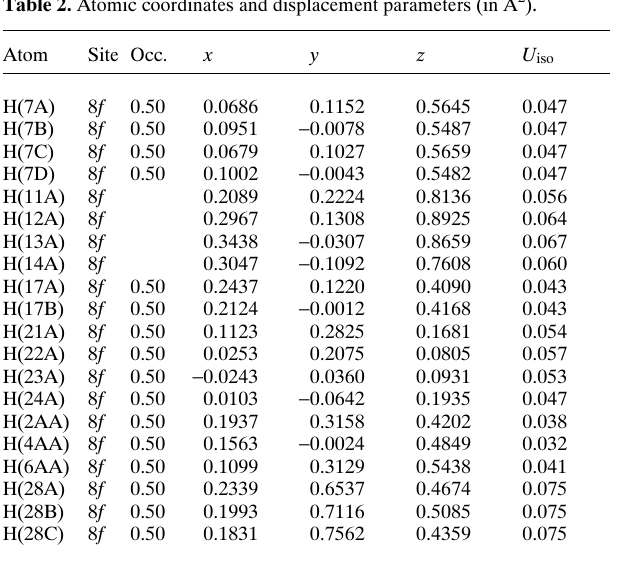
Table 2. Atomic coordinates and displacement parameters (in Å 2 ) .